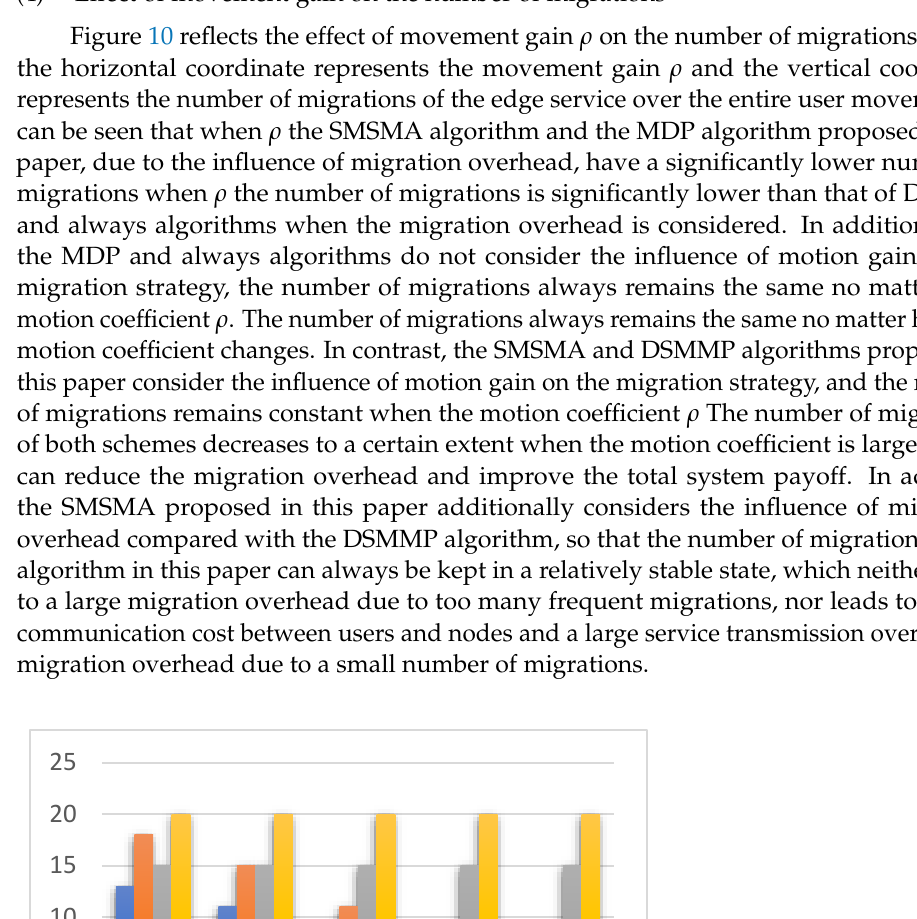
Figure 9. Effect of service size on system total return.